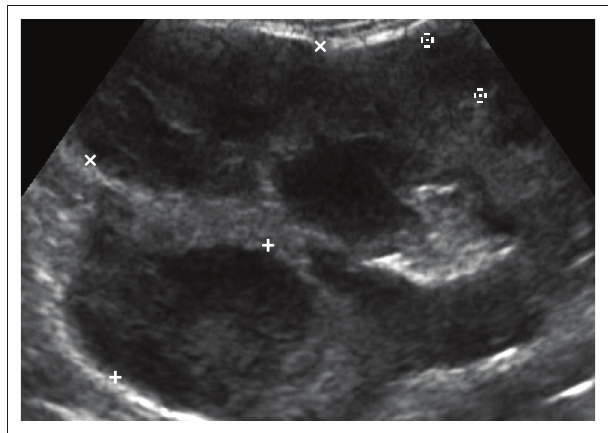
1 µ m FIGURE 10: Right kidney transverse view demonstrating three irregularly rounded heterogenous hypoechoic nodules measuring 1.5 cm, 1.25 cm and 1 cm in diameter respectively (between